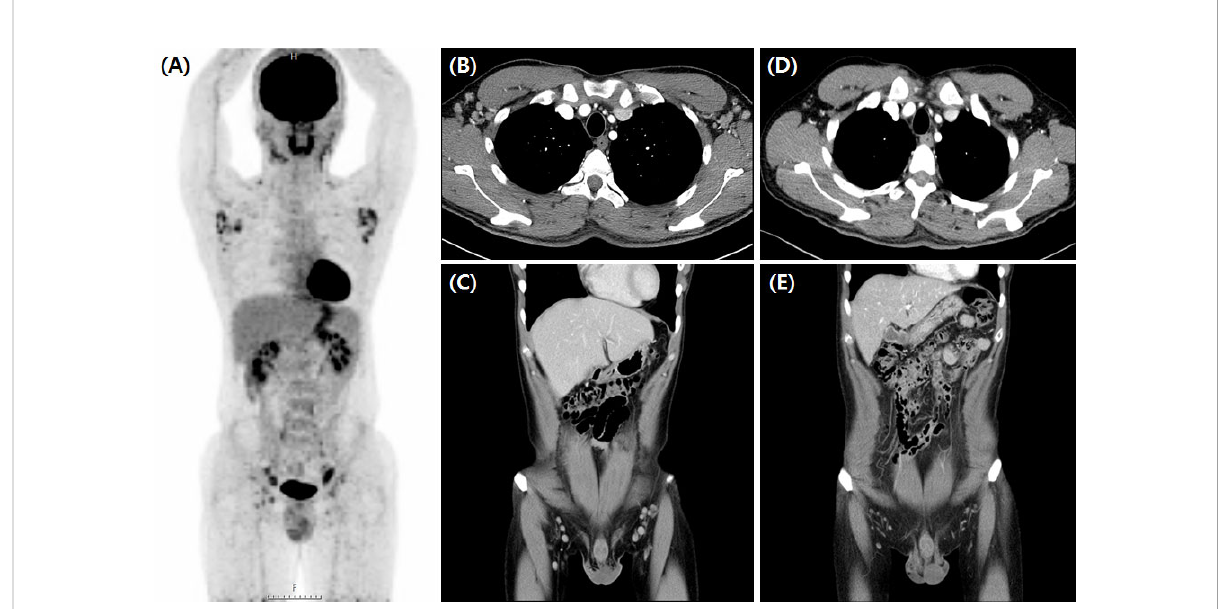
FIGURE 3 Signi fi cant regression of enlarged lymph nodes after third siltuximab infusion. Initial FDG-PET CT scan of iMCD plasma cell type patient (A) showed MCD involving bilateral cervical, supraclavicular, axillae, common and external iliac, and inguinal lymph nodes. CT scan fi ndings before (B, C) and after (D, E) siltuximab infusion showed markedly regressed MCD-involved lymph nodes in the bilateral inguinal and axillar areas. FDG-PET CT, 18- fl uoro-2-deoxy-D-glucose positron emission tomography-computed tomography; iMCD, idiopathic multicentric Castleman